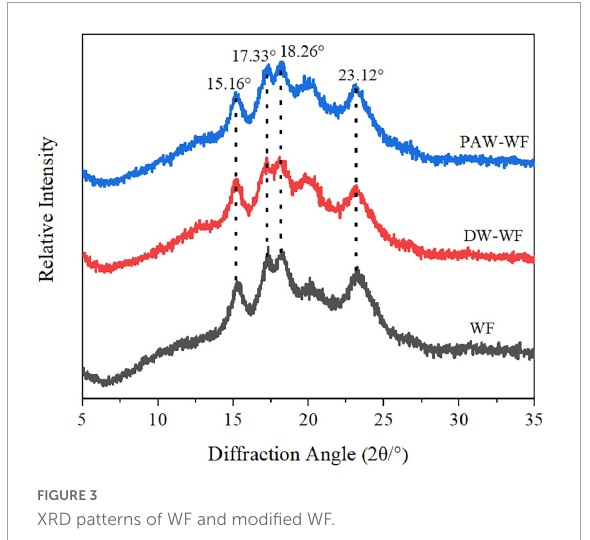
FIGURE3 XRD patterns of WF and modified WF.